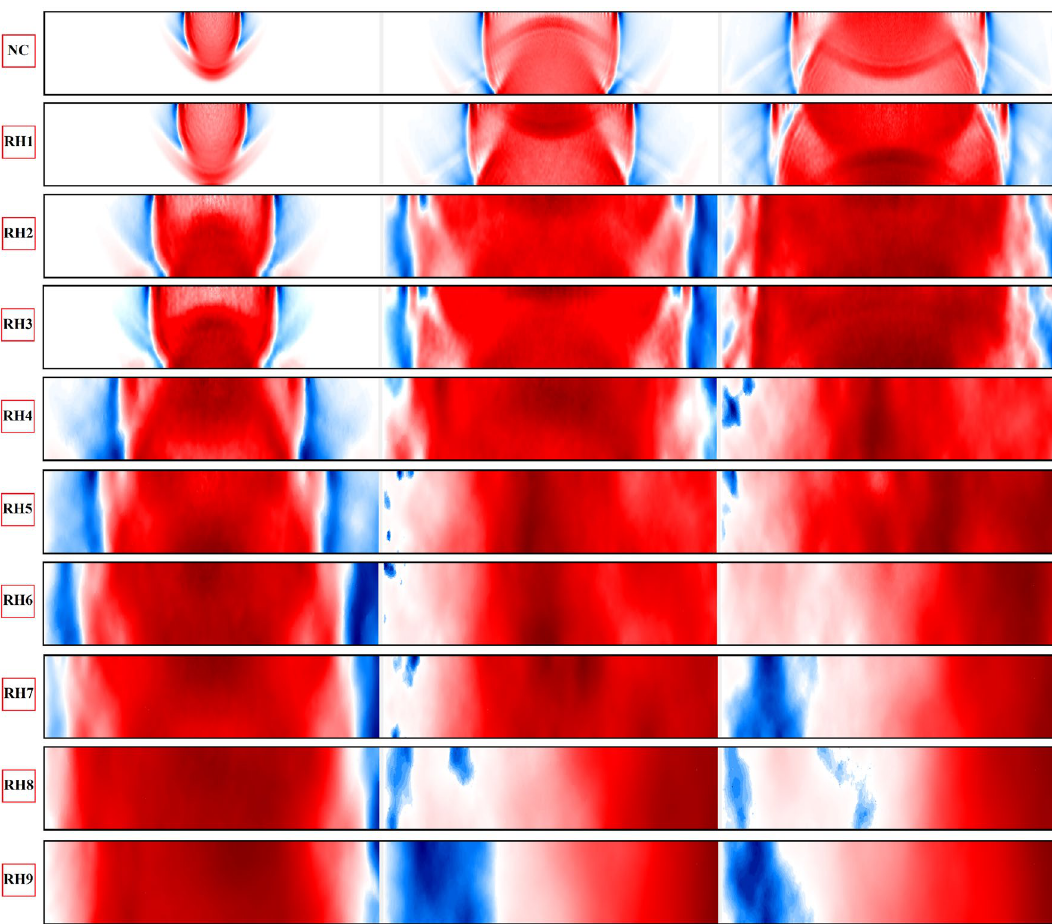
Figure 17. Plotted displacement wave fields in the same time steps (3, 7 and 10 heterogeneity ratios in the rock domain: NC,